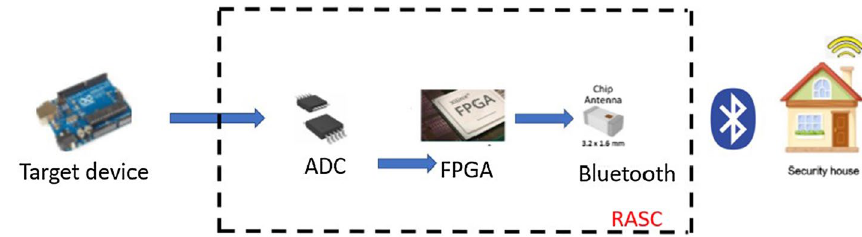
Fig. 3 RASC functional diagram. RASC collects power